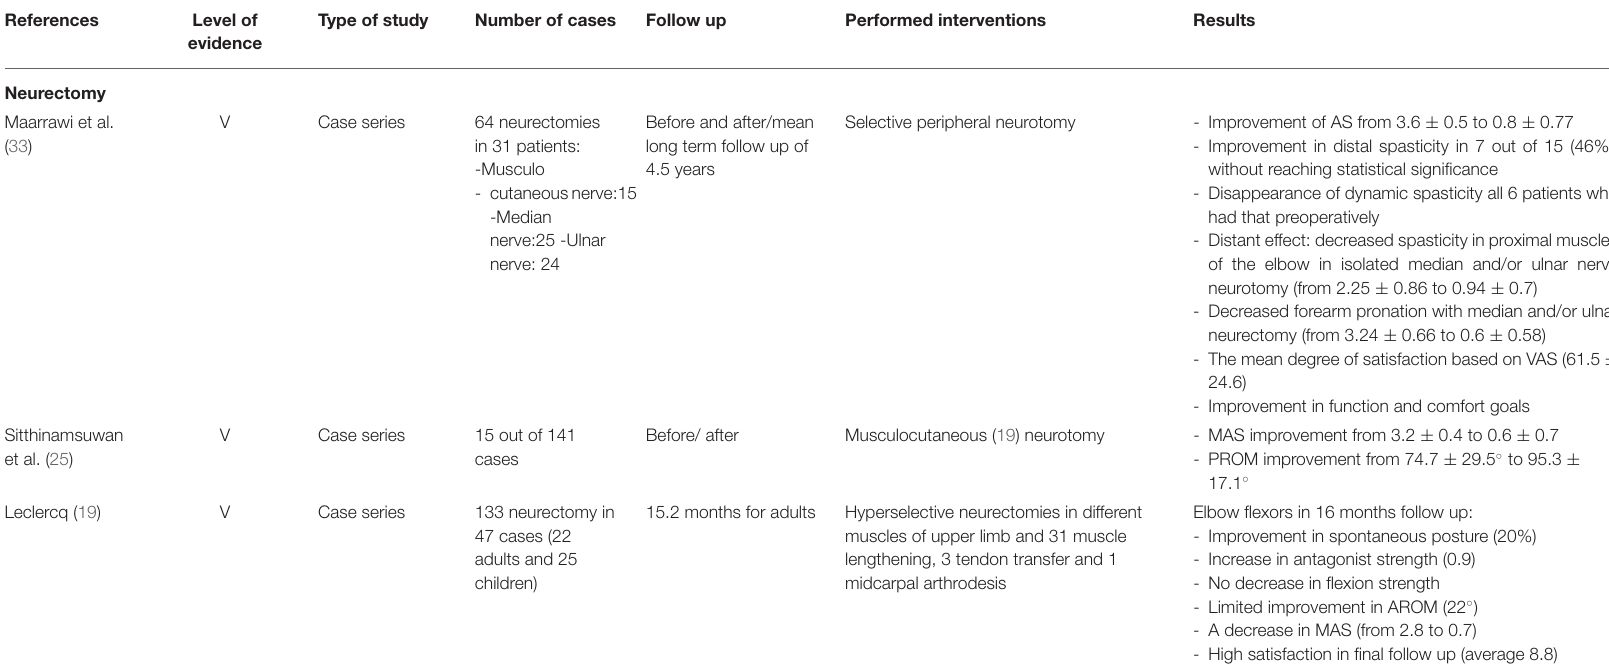
Hyperselective neurectomies in different muscles of upper limb and 31 muscle lengthening, 3 tendon transfer and 1 midcarpal arthrodesis